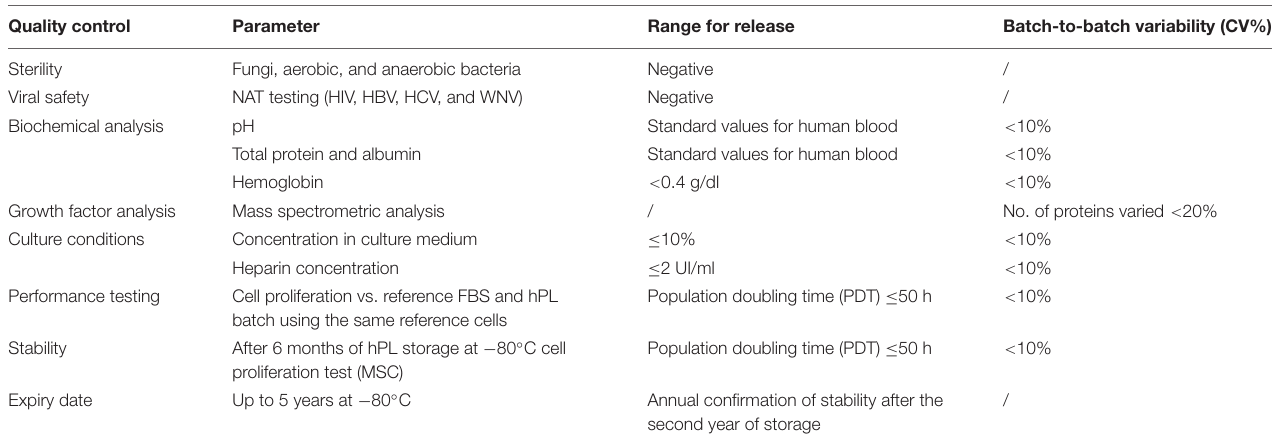
FIGURE 5 | Boxplot of hMSC expansion at 7 days of culture in the presence of hPL4c. At the start of the expansion assay (day 0), 4,000/cm 2 hMSC are seeded in the presence of 5% of three different batches of hPL4c. Cell proliferation is expressed as doubling time (hours). X indicates sample mean. (A) Effect of hPL4c A18 on three different hMSC batches. hPL4c A18 has shown no differences in DT for the three hMSC batches. (B) Effect of hPL4c B18 on three different hMSC batches. hPL4c B18 has shown higher proliferative effect on hMSC3 compared with the other hMSC batches (hMSC1 vs. hMSC3, p = 0.014, and hMSC2 vs. hMSC3, p = 0.029). (C) Effect of hPL4c C18 on three different hMSC batches. hPL4c C18 has shown higher proliferative effect on hMSC3 compared with the other hMSC batches (hMSC1 vs. hMSC3, p = 0.018, and hMSC2 vs. hMSC3, p = 0.026). TABLE 2 | Standards for hPL